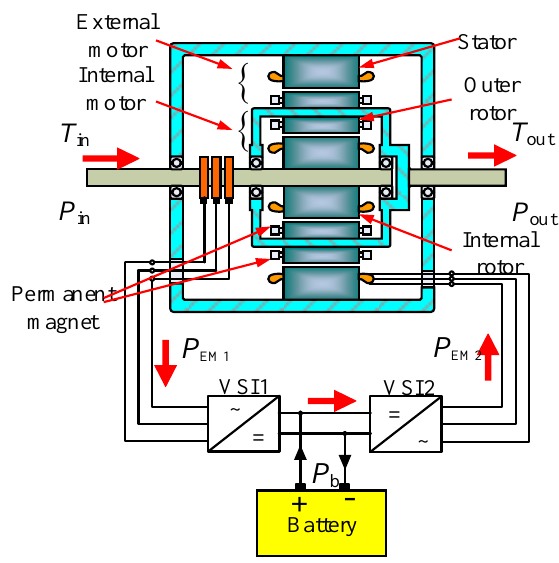
Figure 1. Structure of compound structure permanent-magnet motor.